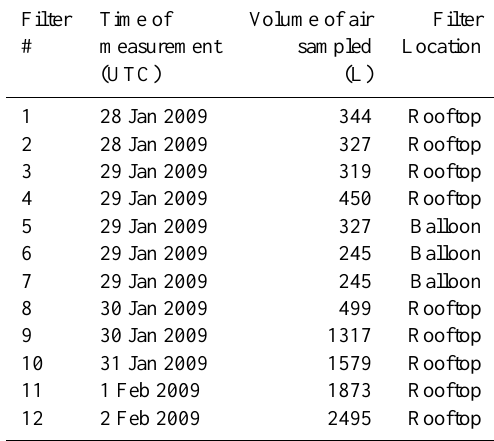
Table 1. Description of sampled